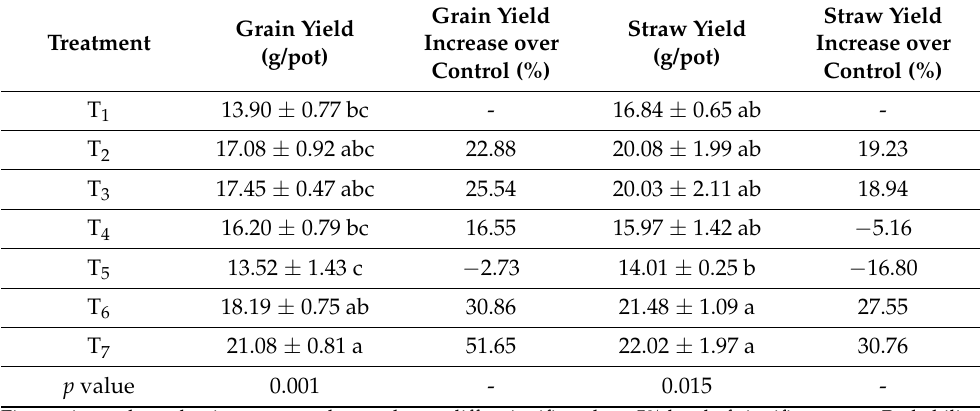
Table 3. Effects of water management on grain and straw yield of rice (cv. BRRI dhan28). Grain Grain Yield Treatment (g/pot)